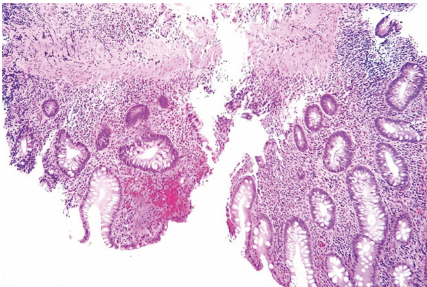
Figure 3: Biopsy ofrectumshowschronicactivecolitis; histopathol- ogy and anatomic distribution of disease are consistent with ulcera- tive colitis (hematoxylin& eosin stain; original magnification